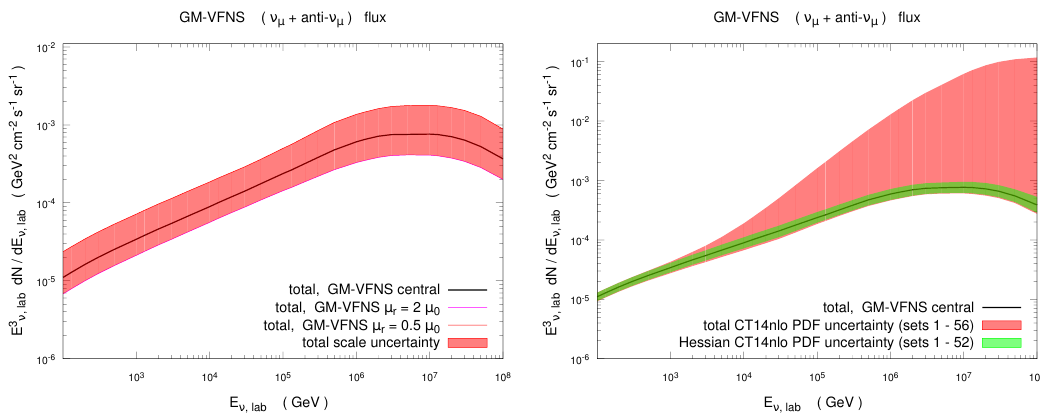
Figure 8 . Predictions for prompt-( (cid:23) (cid:22) + (cid:22) (cid:23) (cid:22) ) (cid:13)uxes as functions of neutrino energy E (cid:23) , according to the GM-VFNS computation presented in this paper. Renormalization scale uncertainties are shown in the left panel, whereas PDF uncertainties are shown in the right panel, separating the contribution due to the Hessian sets (1{52) from the total one due to all 56 PDF sets included in the CT14nlo (cid:12)t. The broken-power-law CR primary input spectrum is used for these plots. See text for more